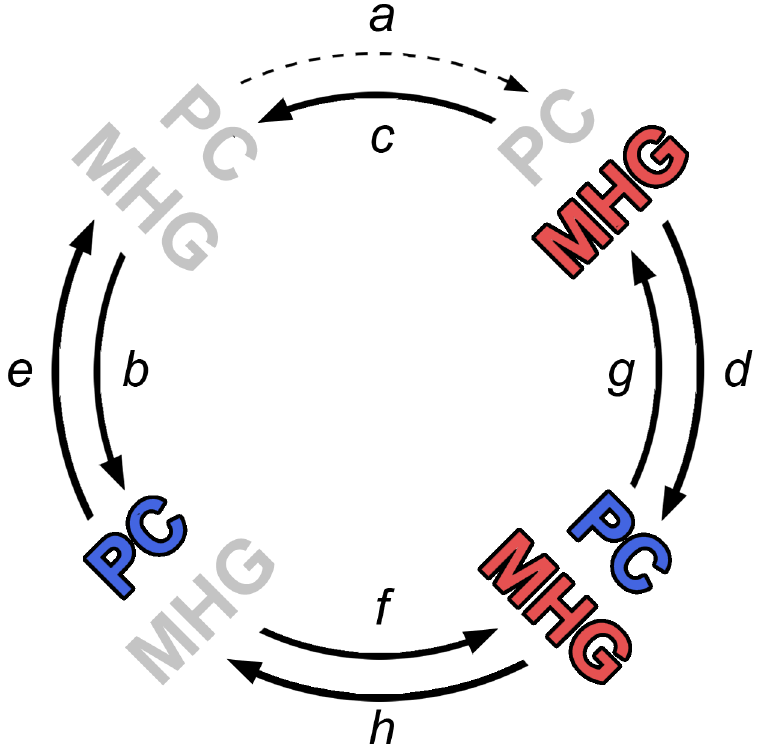
Fig 4. Co-evolutionary model of political complexity (PC) and Moralising High God (MHG) concepts in Austronesia. Grey represents the absence of a trait, and arrows represent rates of change.